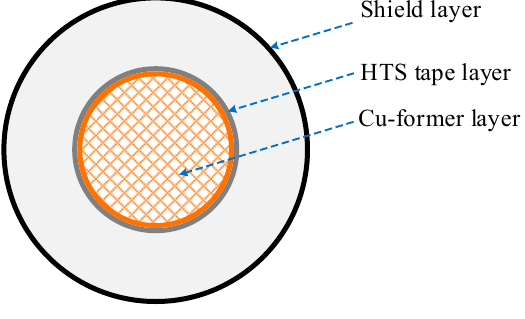
Figure 7. Single-phase HTS power cable.